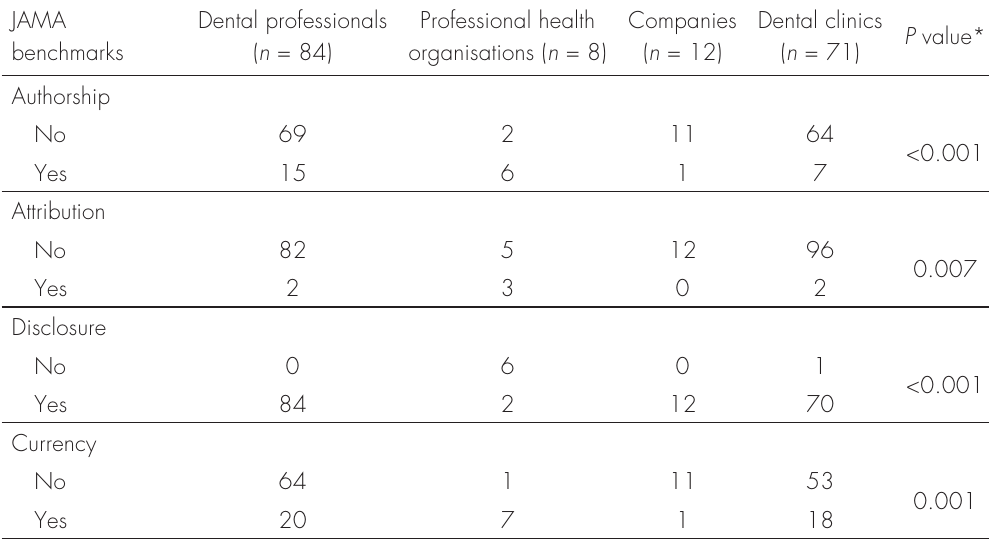
Table II. Comparison of JAMA benchmark scores among the groups.